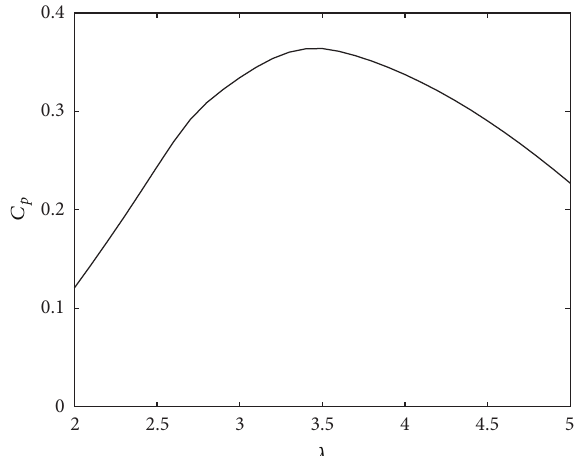
Figure 2: Simulated 𝐶 𝑝 -curve at 1.3m/s for the turbine designed for S¨oderfors according to the streamtube